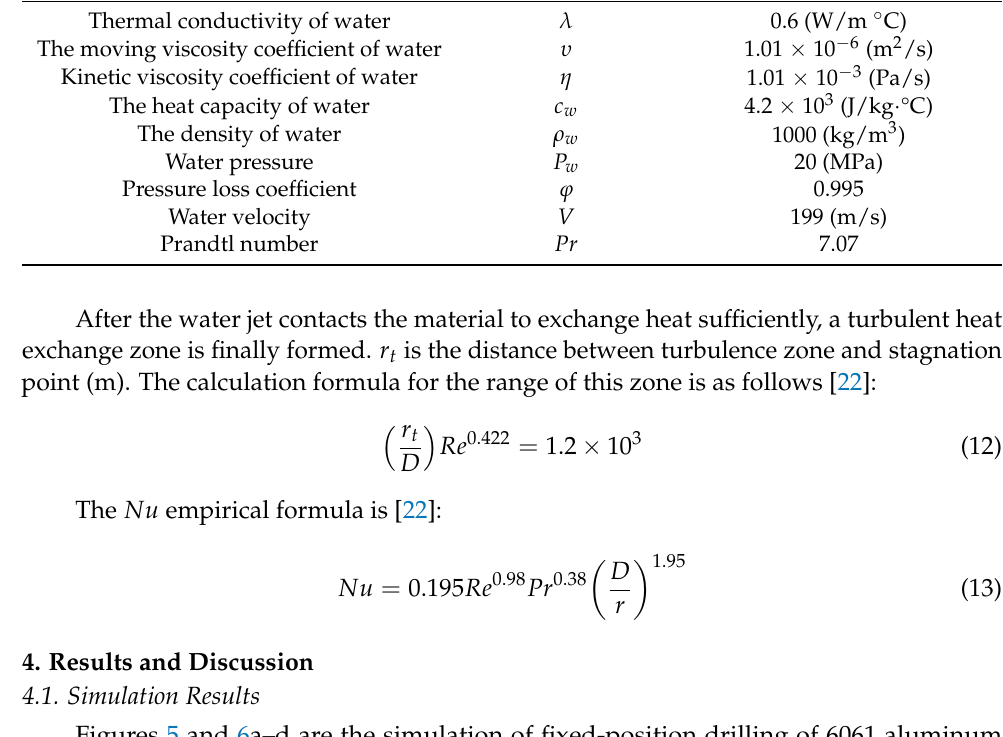
Table 4. The relative parameters of water jet heat transfer coefficient are calculated [23].